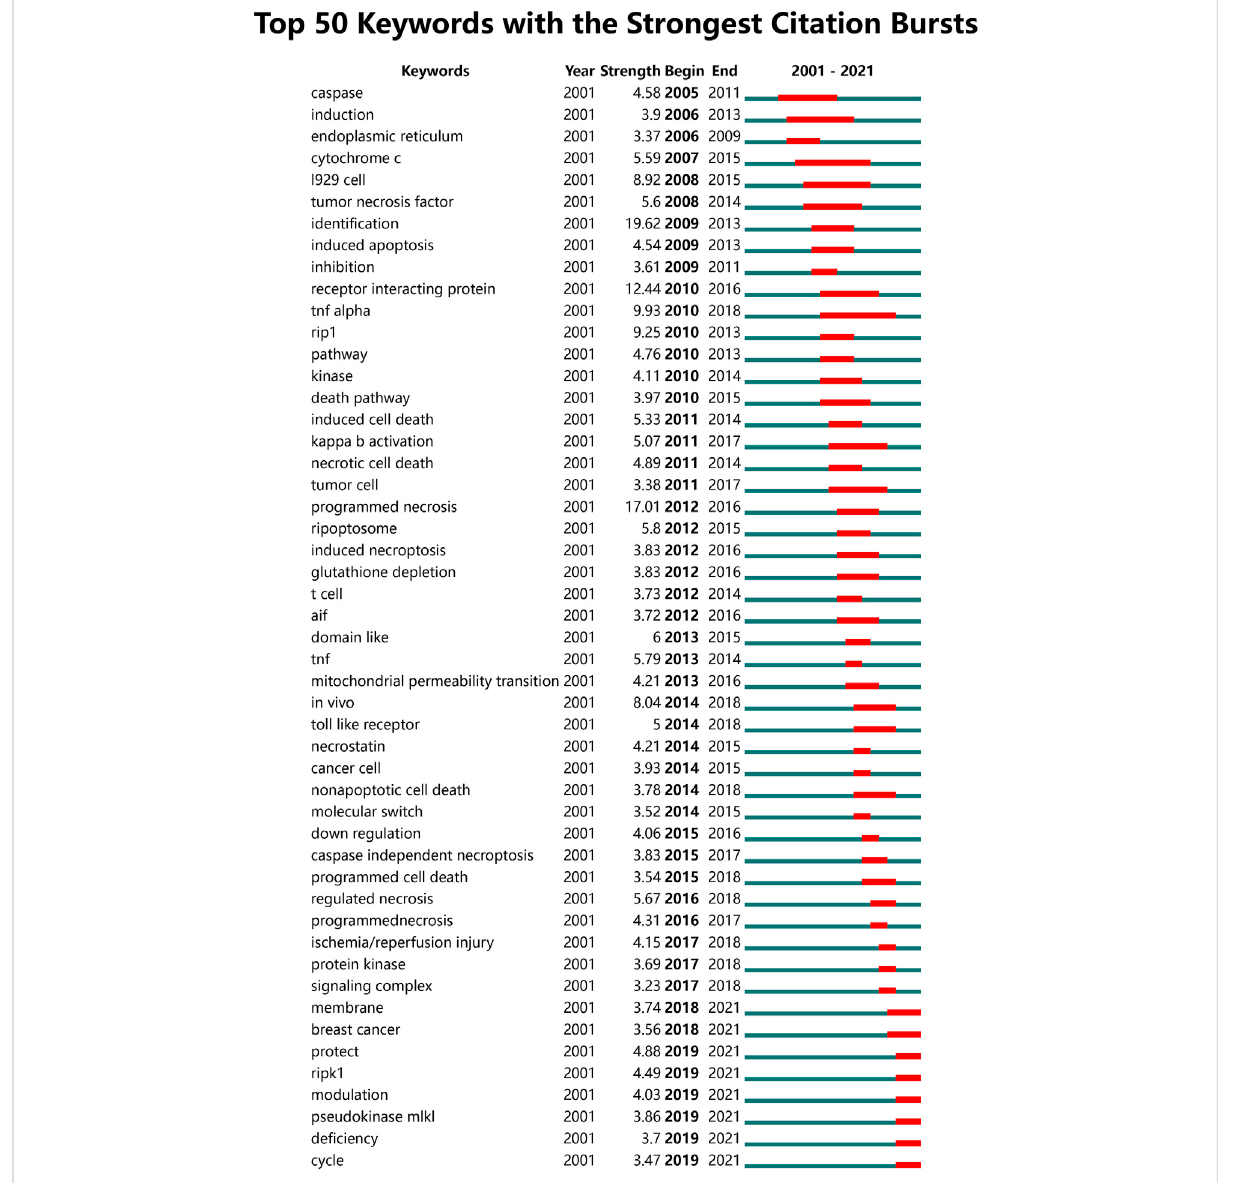
FIGURE 7 The top 50 burst keywords of necroptosis research.